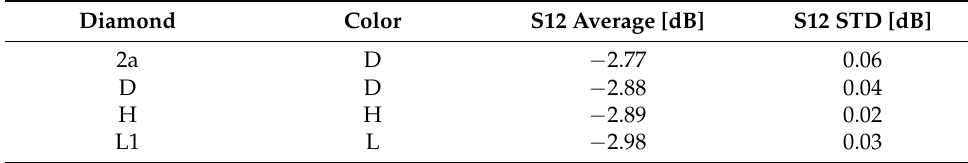
Table 5. Average and STD of S12 at a frequency of 7.0375 GHz for the master diamonds.